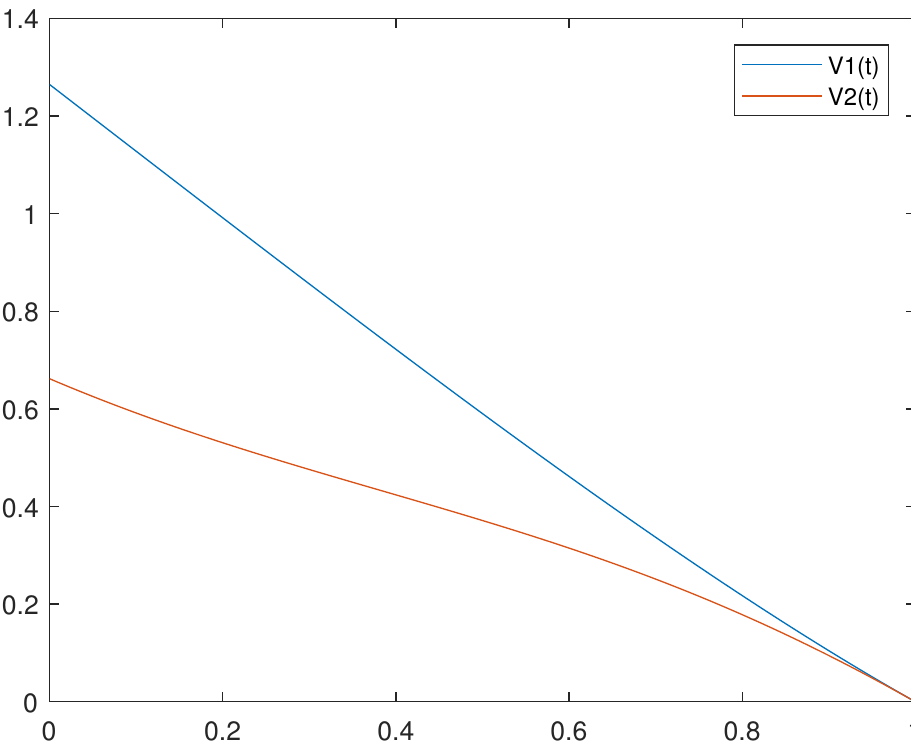
Figure 1. Image of the approximate solutions of v 1 , v 2